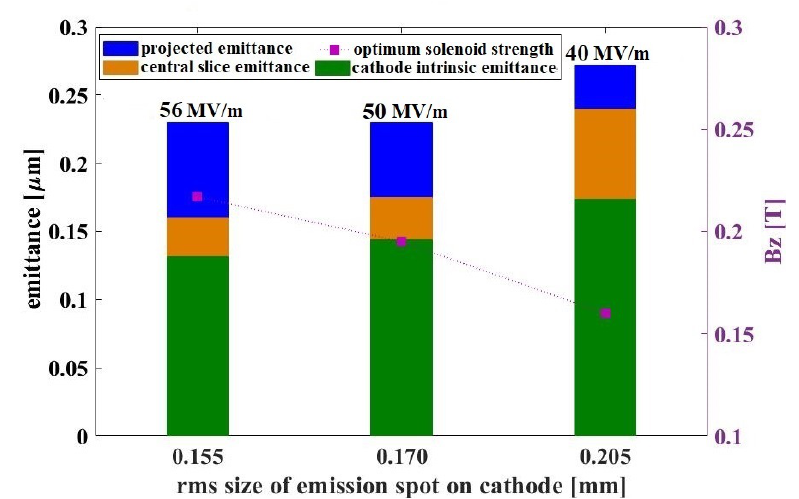
Figure 4. Optimized transverse projected emittance at varied cathode peak accelerating gradients using a nominal Gaussian laser pulse length of 3 ps (rms) at the European XFEL. The solenoid strength, the cathode laser spot size as well as the gun operation phase are optimized for minimizing the projected emittance at the injector exit. The inset numbers represent peak accelerating gradients at the cathode. The purple markers denote the optimum solenoid strength on the right axis. The used gun phases w.r.t. maximal mean momentum gain phase are − 1.25 degrees, − 1.75 degrees and − 3.25 degrees for the 56.3 MV/m, 50 MV/m and 40 MV/m cases, respectively.